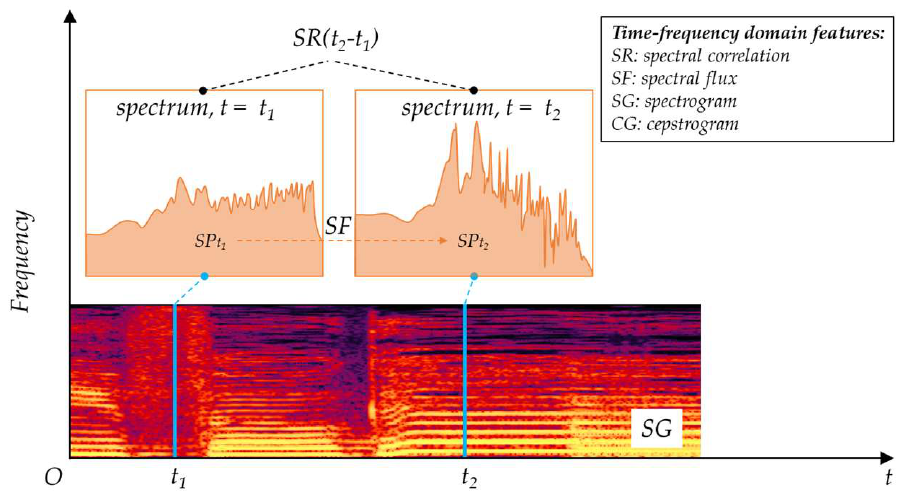
Figure 8. Time-frequency-domain features.